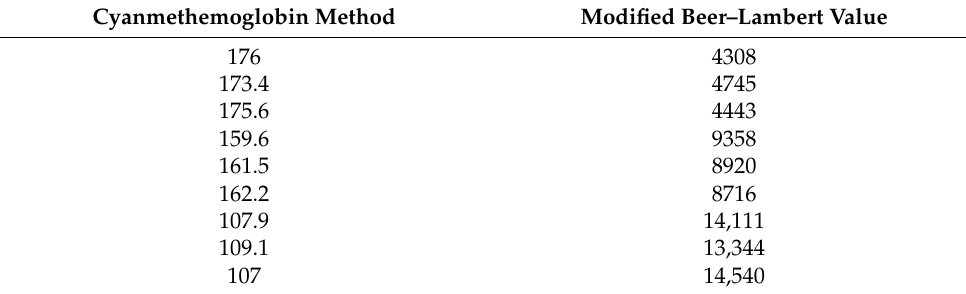
Table 4. Data measured by the modified Beer–Lambert value and cyanmethemoglobin method. Cyanmethemoglobin Method